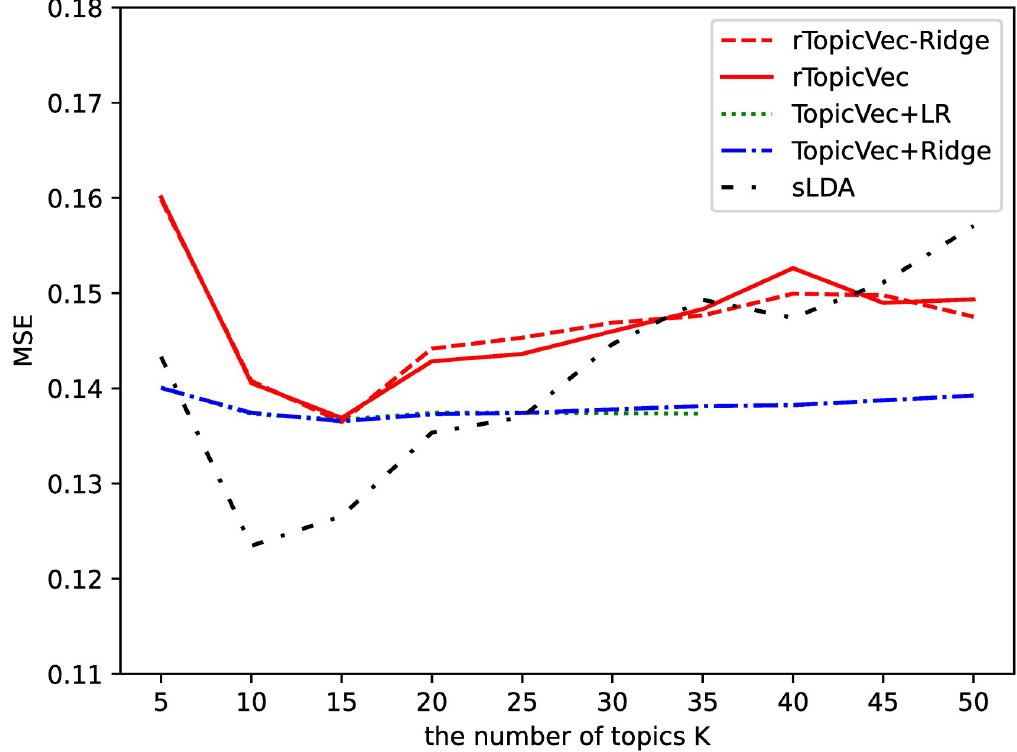
Fig 4. Average MSE for varying number of topics K on validation sets of movie rating score